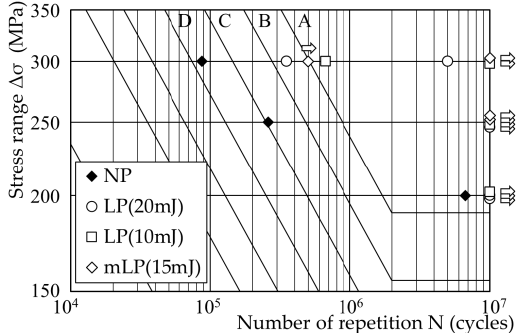
Figure 15. Results of fatigue test.